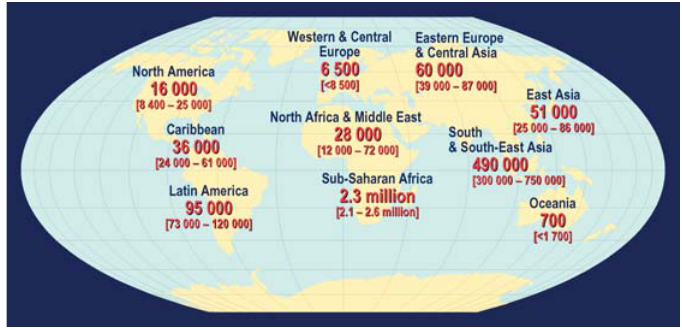
Figure 3. Estimated Adult and Child Deaths from AIDS during 2004 (Total: 3.1 [2.8–3.5]